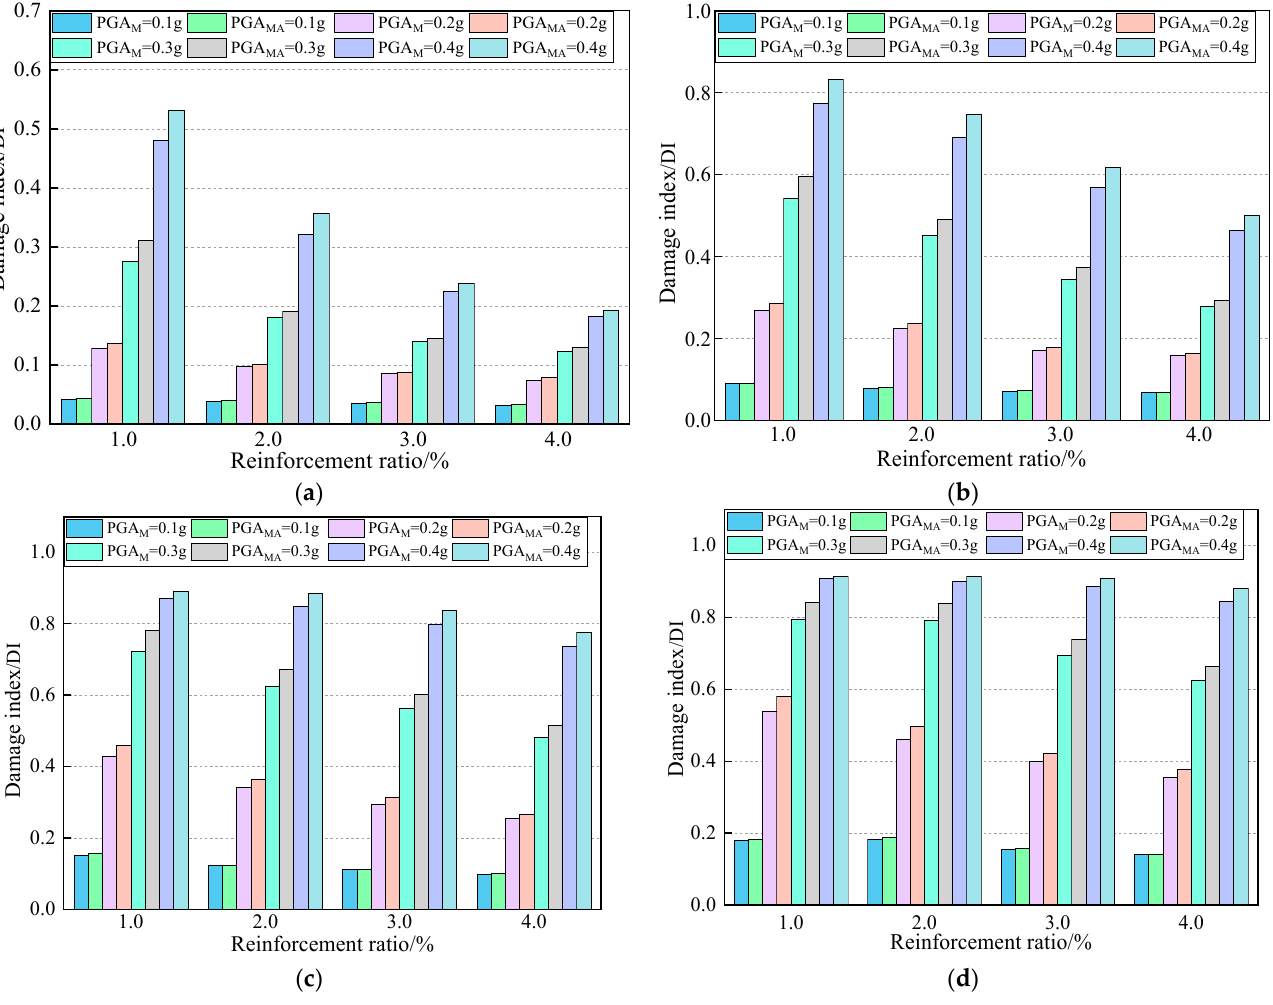
Figure 6. Damage index of the column under MS-AS: ( a ) µ = 0.05; ( b ) µ = 0.1; ( c ) µ = 0.15; ( d ) µ = 0.2.